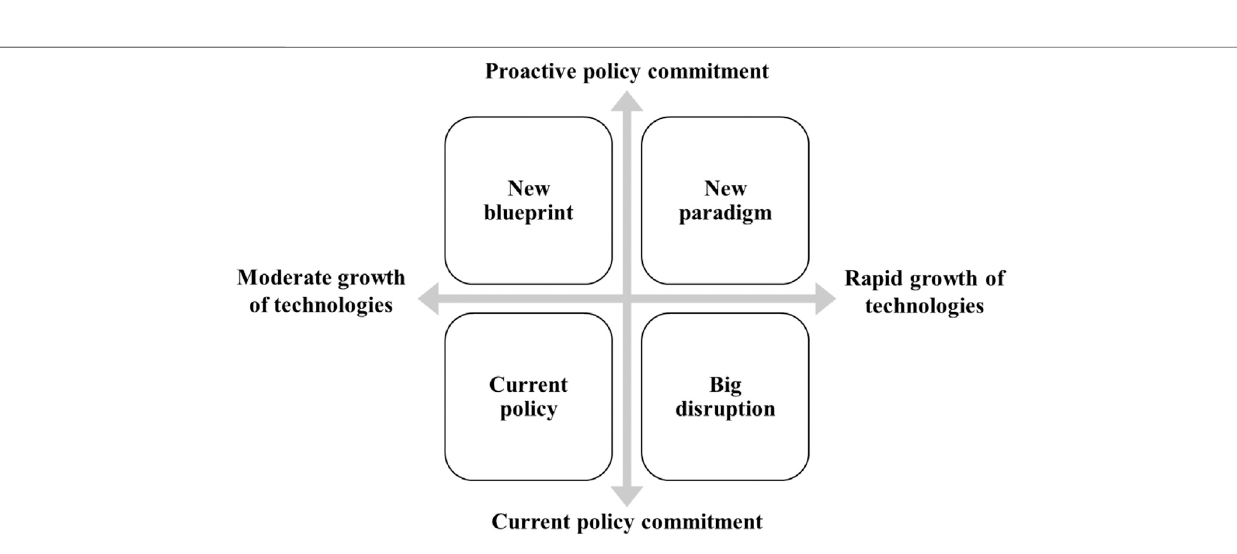
FIGURE 9 | Plausible scenarios of Thai energy business in the next 30